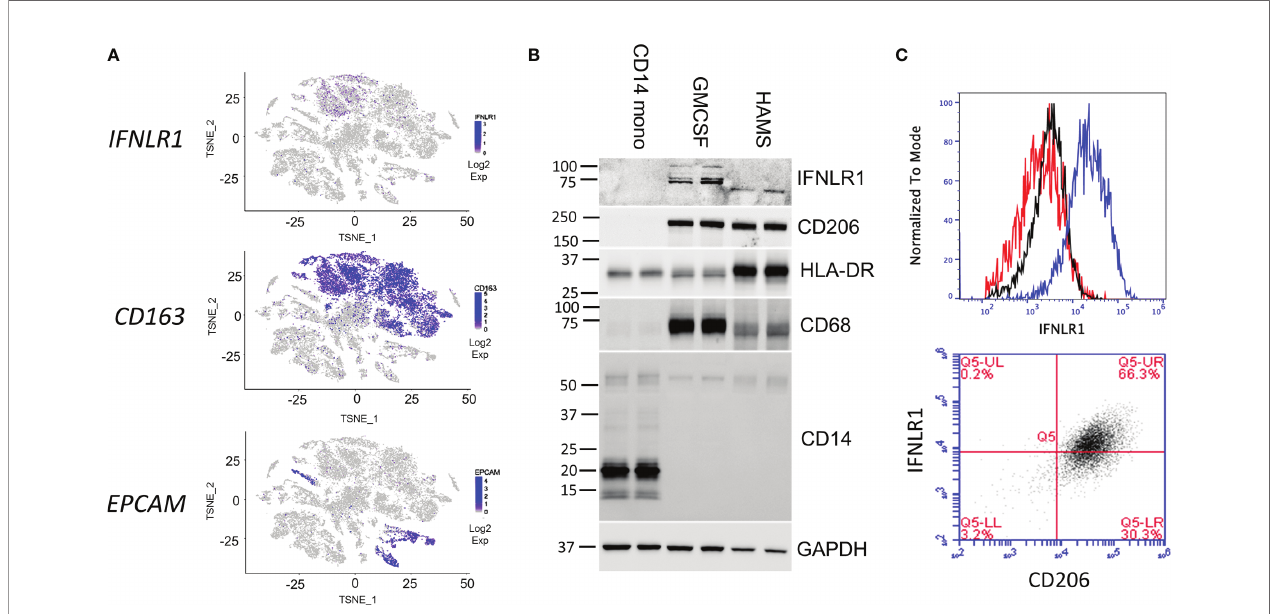
FIGURE 2 | Human alveolar macrophages express functional IFNLR1. Two-dimensional T-distributed stochastic neighbor embedding (t-SNE) plots were generated based on global gene expression relationships. IFNLR1 and two marker genes, the human alveolar macrophage (HAMs) marker CD163 and epithelial cell marker EPCAM, were displayed with level of intensity of blue (A) . CD14 monocytes were immediately harvested. Macrophages were differentiated in GM-CSF for 7 days prior to harvest. HAMs were lavaged from transplant rejected lungs, plated overnight prior to harvest. We performed SDS PAGE and examined IFNLR1 expression, and the expression of monocyte (CD14) and macrophage (CD206, MHCII, CD68) markers in the three cell types. (B) . HAMs were plated for 24h and subjected to fl ow cytometry analysis with antibodies again IFNLR1 and CD206. Top: Flow cytometry analysis of fl uorescent intensity in unstained (red), phycoerythrin (PE) isotype incubated (black), and IFNLR1-PE incubated HAMs (blue). Bottom: IFNLR1 expression in CD206 positive cells (C) . n =2 independent experiments (B, C)